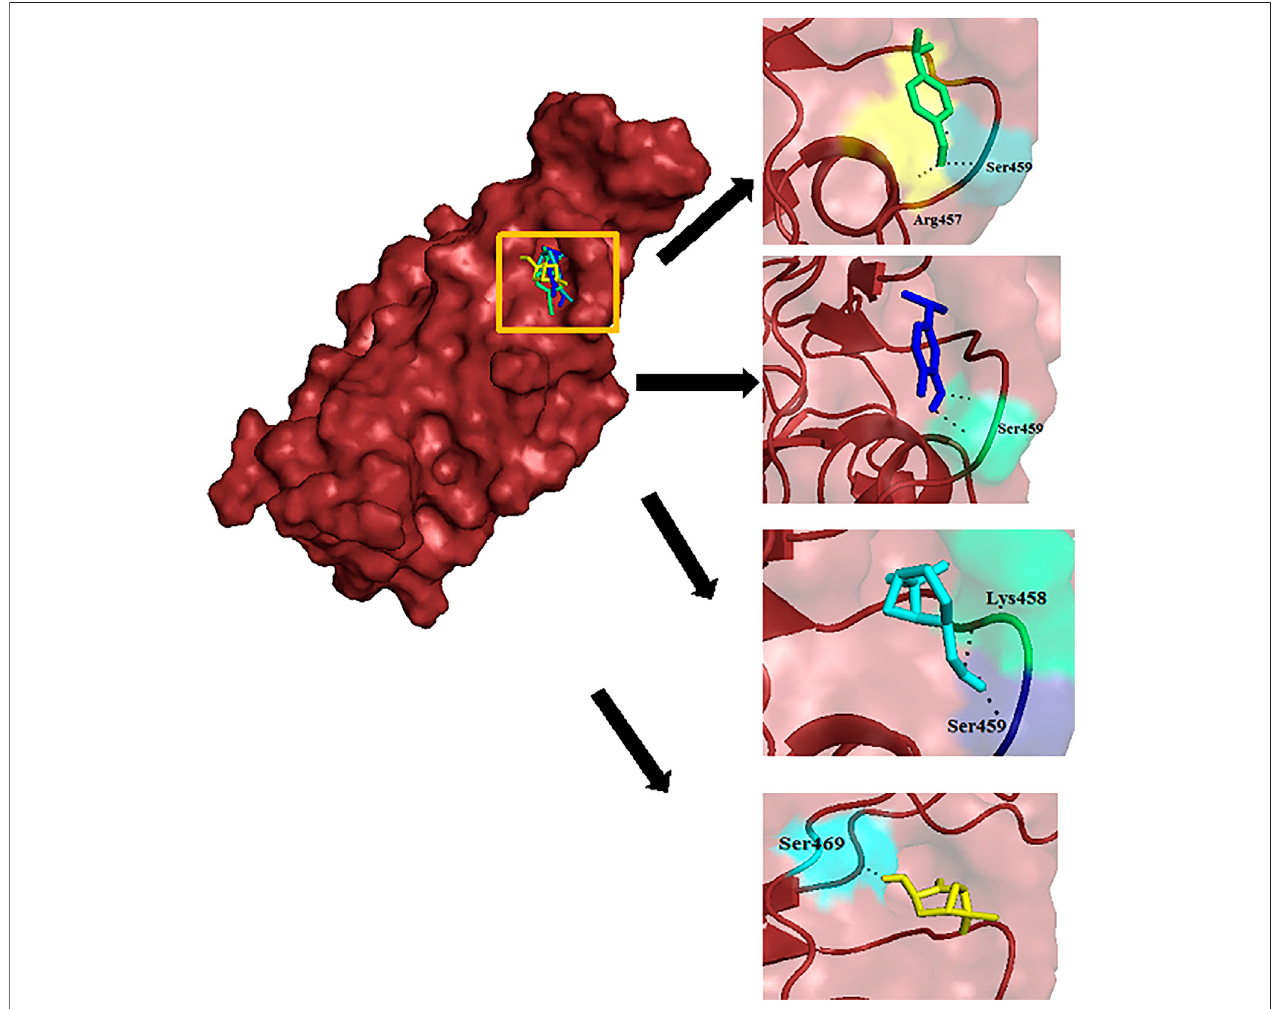
FIGURE 2 | Docked poses of cuminal (green), carvacrol (blue), myrtanol (teal), and pinocarveol (yellow) in the binding site of the RBD of S glycoprotein. The hydrogen bonding between ligands and amino acid residues is depicted.